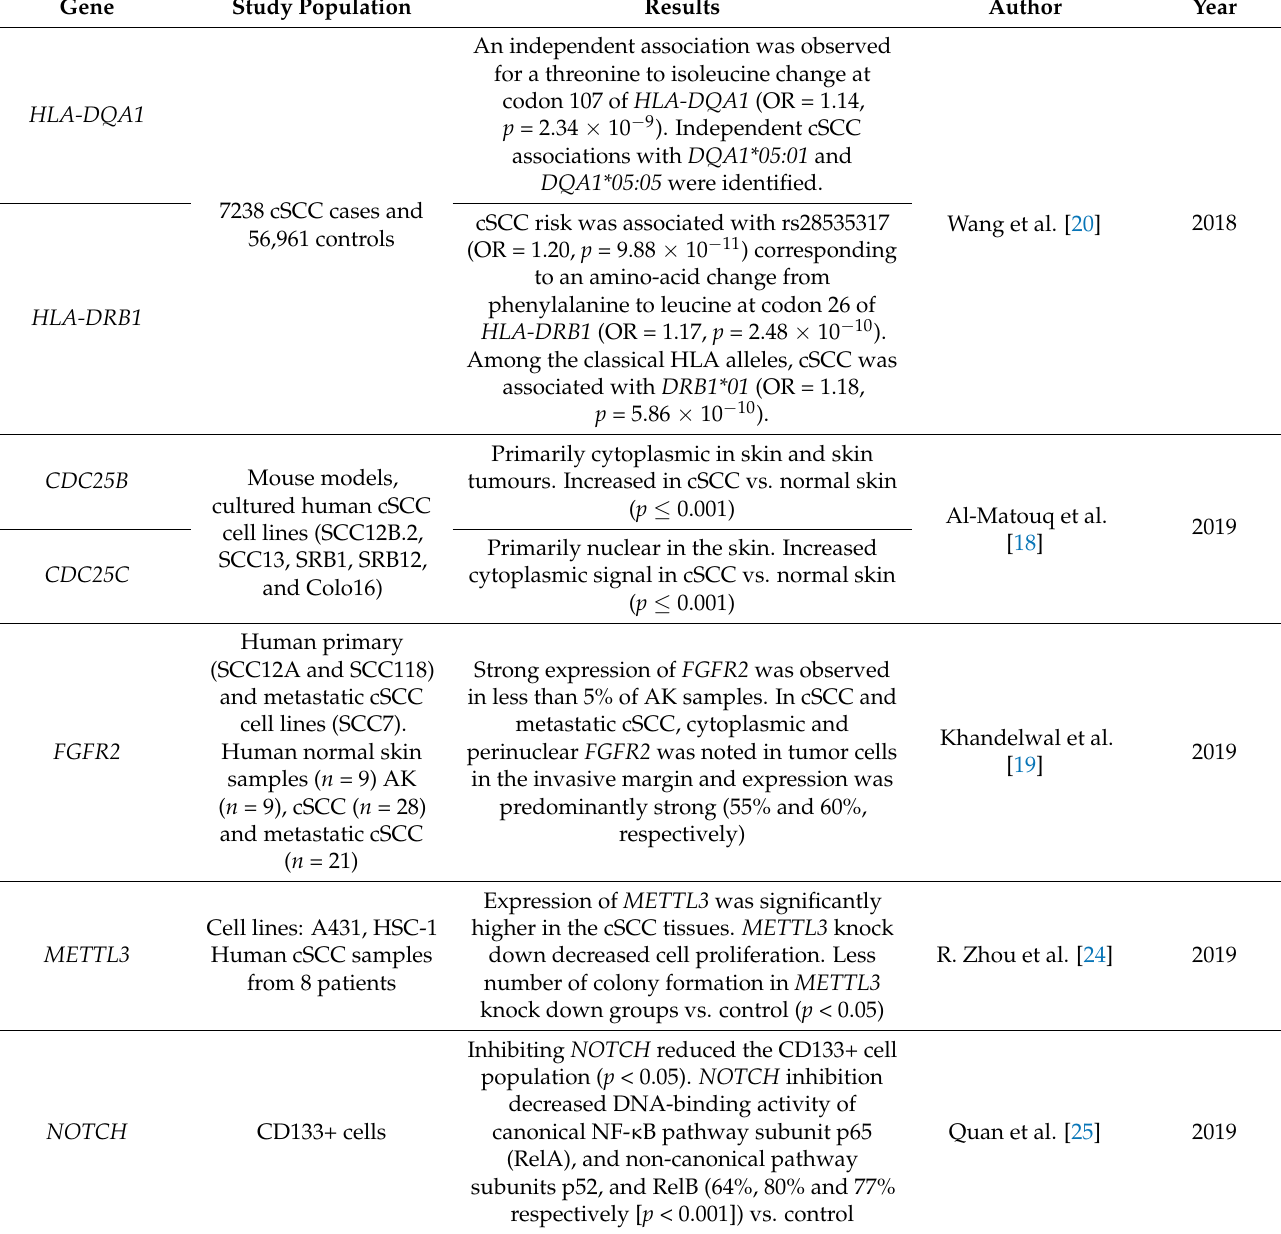
Table 4. Genes with oncogenic